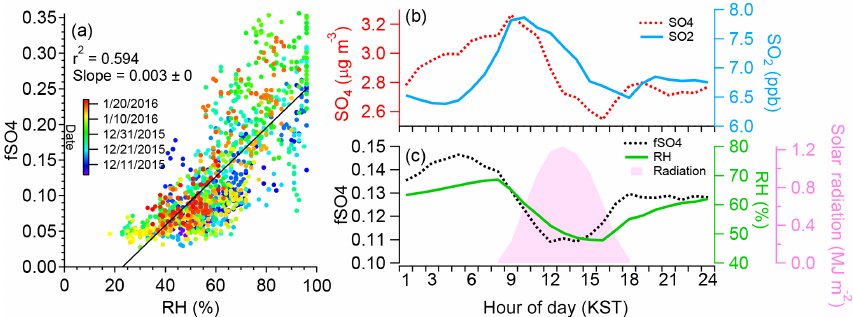
Figure 6. (a) Scatterplot of the variations in f SO 4 ratios as a function of RH. (b) Diurnal profiles, 1h averaged, of SO 2 and SO 4 , and (c) 1h averaged diurnal profiles of f SO 4 , RH, and solar radiation. The solar radiation measurement site is located at 20km away from the measurement site.